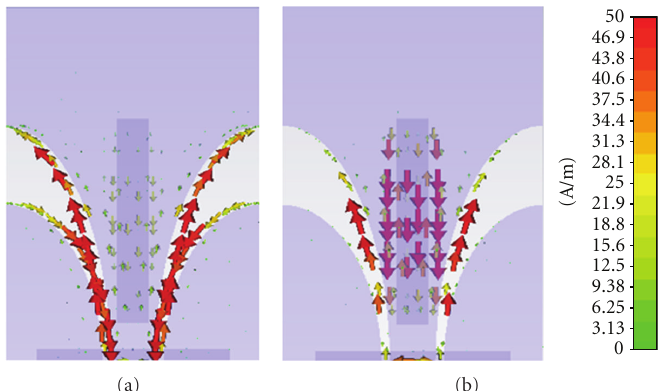
Figure 5: Simulated current distribution of the notched UWB antenna at (a) 3.4GHz (normal operation frequency) and (b) 5.8 GHz (notched frequency).